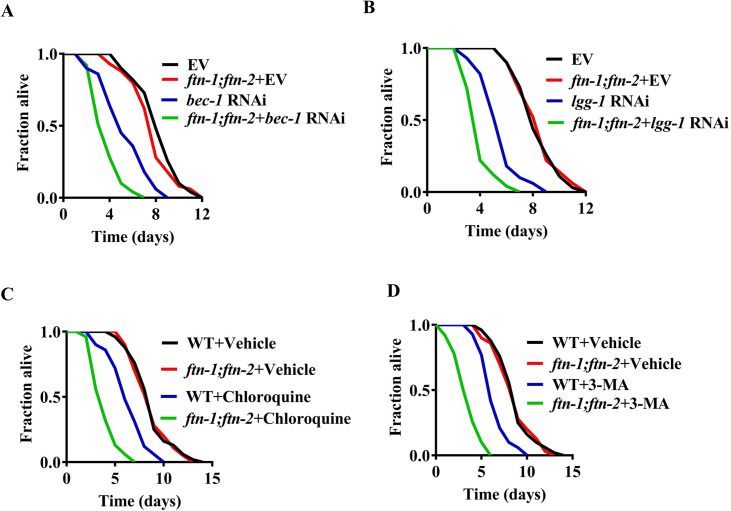
Ferritin is required for defense against S. Typhimurium infection after autophagy is inhibited.(A and B)
ftn-1(ok3625);ftn-2(ok404) double mutants were more susceptible to killing by S. Typhimurium than wild-type (WT) worms when bec-1 (A) or lgg-1 (B) is silenced by RNAi. P< 0.01, bec-1 or lgg-1 RNAi relative to empty vector (EV); P< 0.01, ftn-1;ftn-2+bec-1 or lgg-1 RNAi relative to bec-1 or lgg-1 RNAi. Underlying data are available in S1 Table. (C and D) Chloroquine (C) or 3-methyladenine (3-MA) (D) treatment reduced survival rate of ftn-1(ok3625);ftn-2(ok404) double mutants after S. Typhimurium infection. P< 0.01, WT+Chloroquine or 3-MA relative to WT+Vehicle; P< 0.01, ftn-1;ftn-2+Chloroquine or 3-MA relative to WT+Chloroquine or 3-MA. p-Values throughout were calculated using a Log-rank test. Underlying data are available in S1 Table.